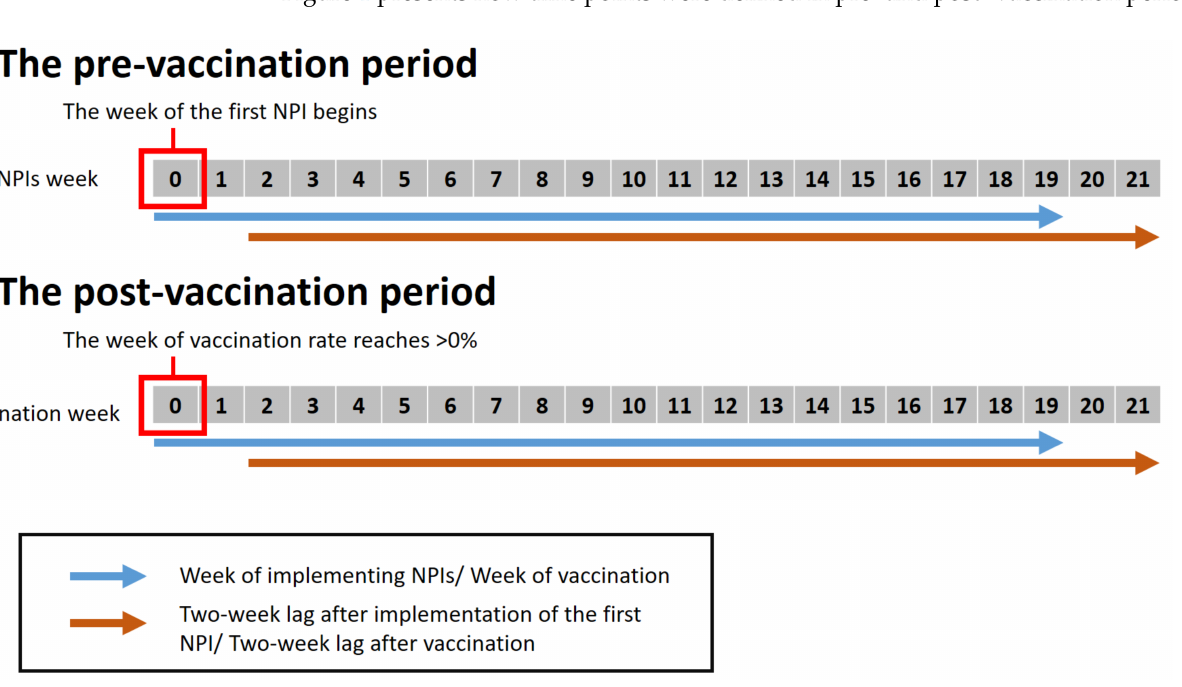
Figure 1. The definition of study